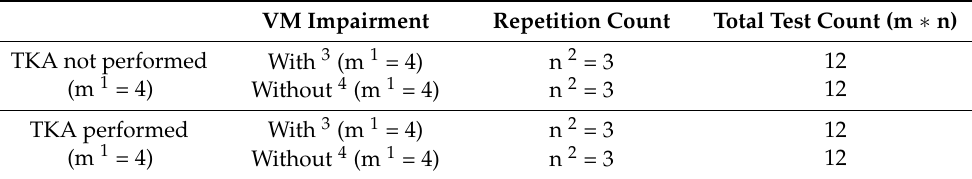
Figure 2. Test configurations for muscle forces and directions (RF: rectus femoris; VI: vastus intermedius; VL: vastus lateralis; VM: vastus medialis) applied to the knee joint and the coordinate system (Fx: anterior – posterior reaction force; Fy: medial – lateral reaction force; Fz: proximal – distal reaction force; Tx: varus – valgus moment; Ty: flexion – extension moment; Tz: internal – external moment) on the knee joint and their degrees of freedom (T1: proximal – distal displacement on the femur; R2: flexion – extension rotation on the femur; R4: flexion – extension rotation on the tibia): ( a ) frontal view; ( b ) sagittal view for each flexion angle (0°, 30°, 60°, and 90°). Table 1. Test conditions and total test count performed in the current study.